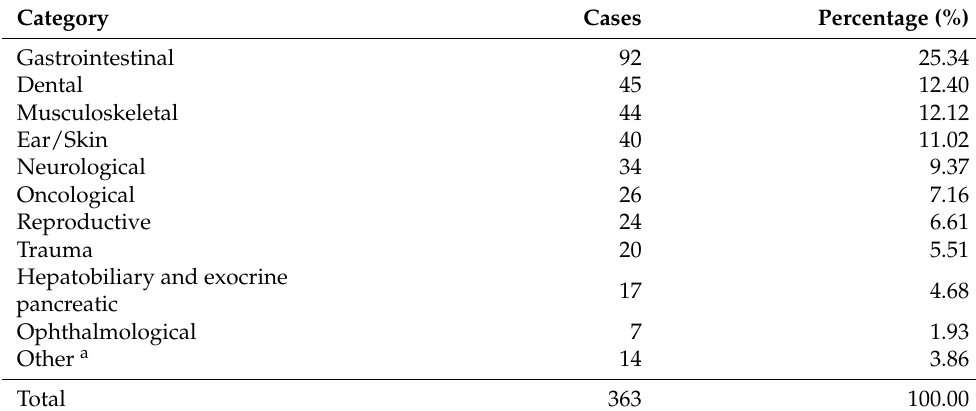
Table 2. The common disease categories of veterinary care among MWDs.